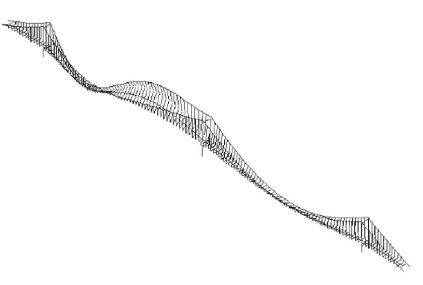
Figure 12: Aerostatic instability form of WYB under an initial attack angle of 0 ∘